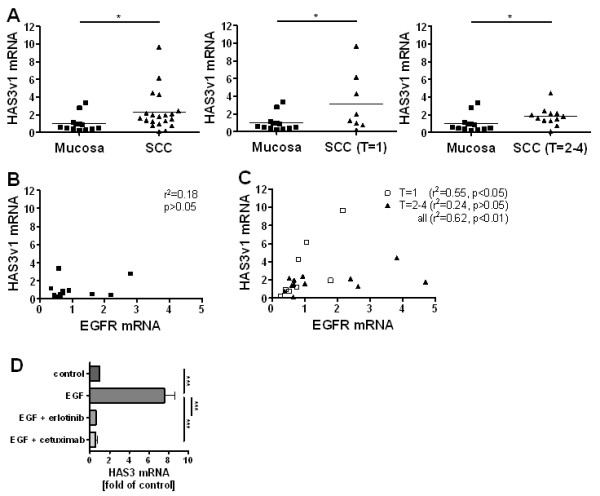
HAS3 was upregulated and correlated with EGFR in human ESCC. (A) Real-time PCR of HAS3 mRNA from biopsy specimens from normal mucosa (n = 13) and human ESCC differentiated into TNM staging (defining tumour size (T), lymph node involvement (N) and existence of metastases (M)) (n = 20), mean ± SEM, *, p < 0.05. (B, C) EGFR expression was determined in the same biopsy specimens as in (A) and correlated to HAS3 expression in normal mucosa (B) and in ESCC (C). HAS3 expression was significantly correlated to EGFR expression in ESCC. (D) EGF stimulated HAS3 mRNA expression in the human ESCC cell line OSC1. This effect was rescued by use of the EGFR tyrosine kinase inhibitor erlotinib and the molecular anti-EGFR antibody cetuximab. Data are mean ± SEM; n = 3-5; ***, p < 0.001.